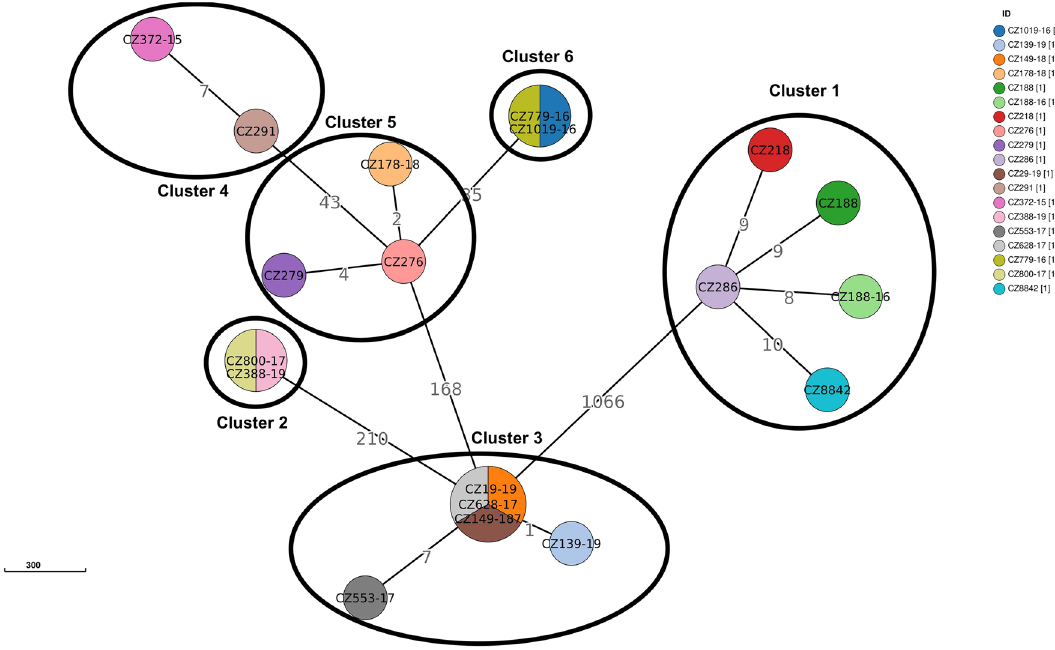
Figure 3. Minimum spanning tree based on SNP differences between the strains, including the XDR-TB and MDR-TB strains collected in Czech Republic during 2005 and 2020. Maximum distance set to 12 SNPs for linked transmission. Distant matrix generated from MTBseq (version 1.0.2, https:// github. com/ ngs- fzb/ MTBseq_ source) and a minimum spanning tree was constructed using GrapeTree software (https:// achtm an- lab. github. io/ Grape Tree/ MSTree_ holder.